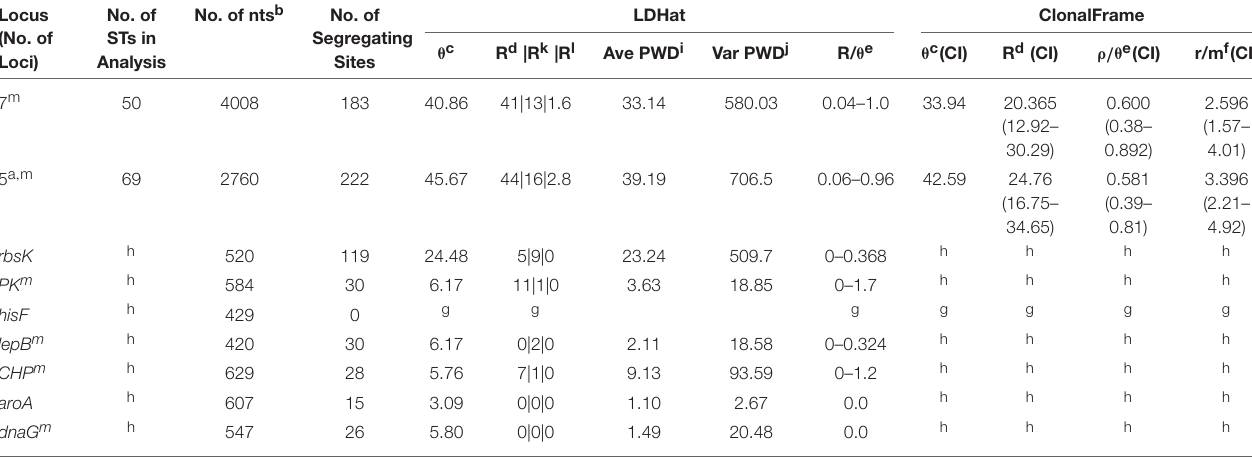
TABLE 1 | Results from recombination and mutation rate and ratio analyses for A-like Synechococcus BACs. Locus (No.